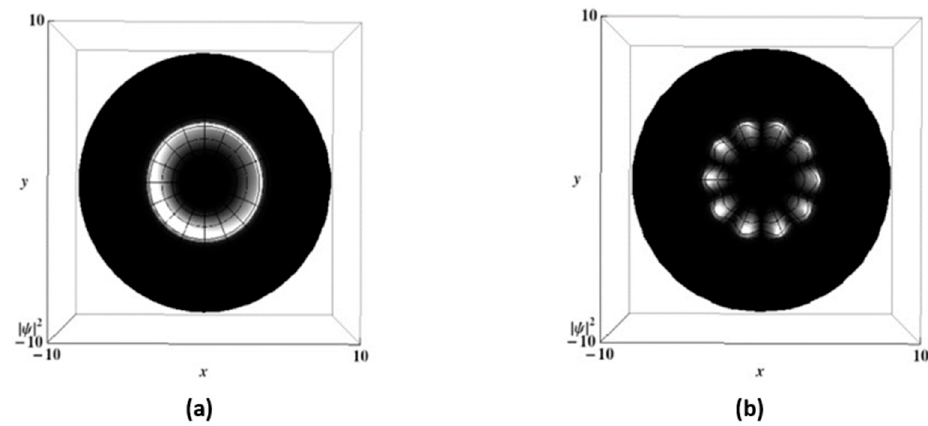
Figure 2. Superposition of coplanar optical vortices. ( a ) Equally charged with m = 5 overlapped to produce an optical vortex with constructive interference; ( b ) Oppositely charged vortices with m 1 = 5 and m 2 = − 5 overlapped to produce 2 m interference fringes.